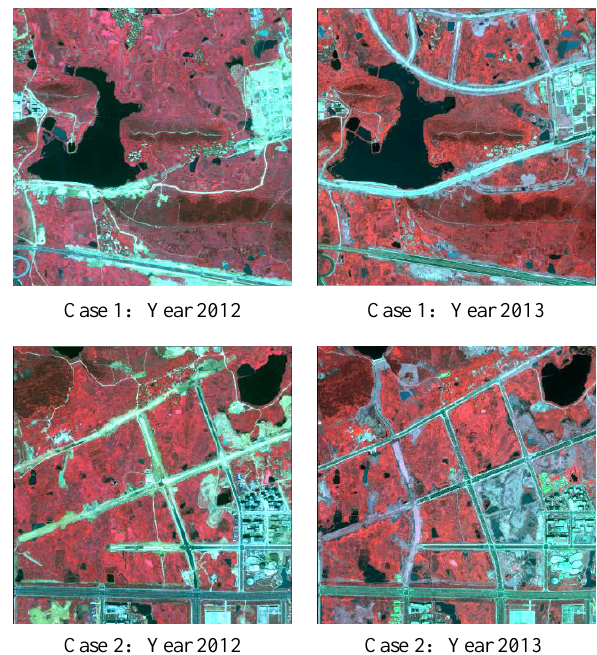
Figure 1 Test Data